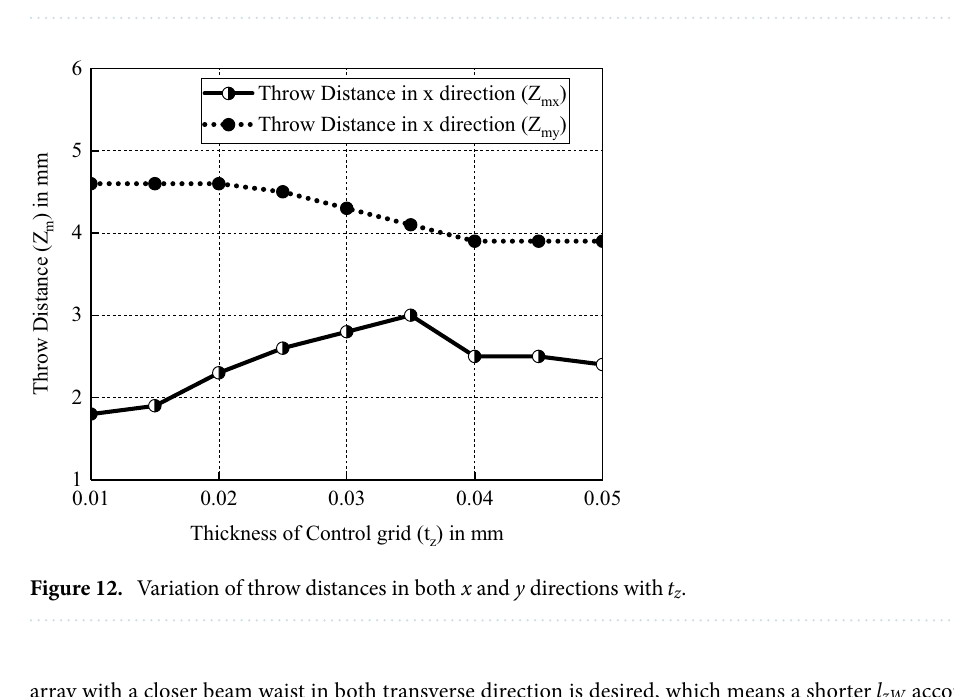
Figure 11. ( a ) Variation of throw distances in both x and y directions with l zW . ( b ) Variation of aspect ratio of beam cross section at beam waist in y direction with l zW .